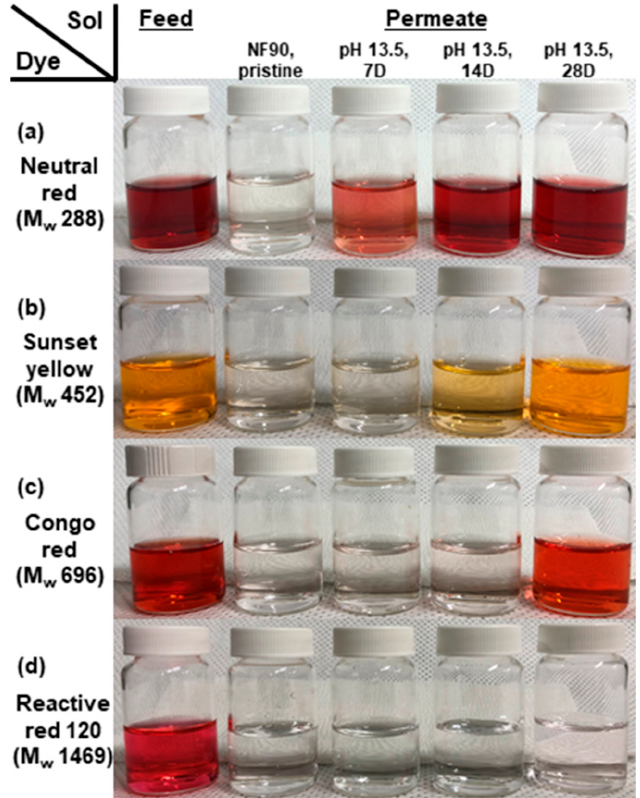
Figure 7. Series of photos showing dye removal using NF 90 pristine and post-treated membranes. Used dyes are ( a ) Neutral red, ( b ) Sunset yellow, ( c ) Congo red, and ( d ) Reactive red 120.